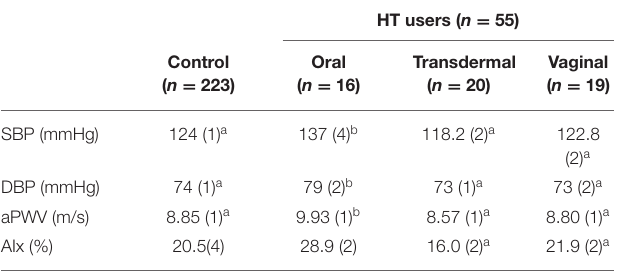
Frontiers in Cardiovascular Medicine |